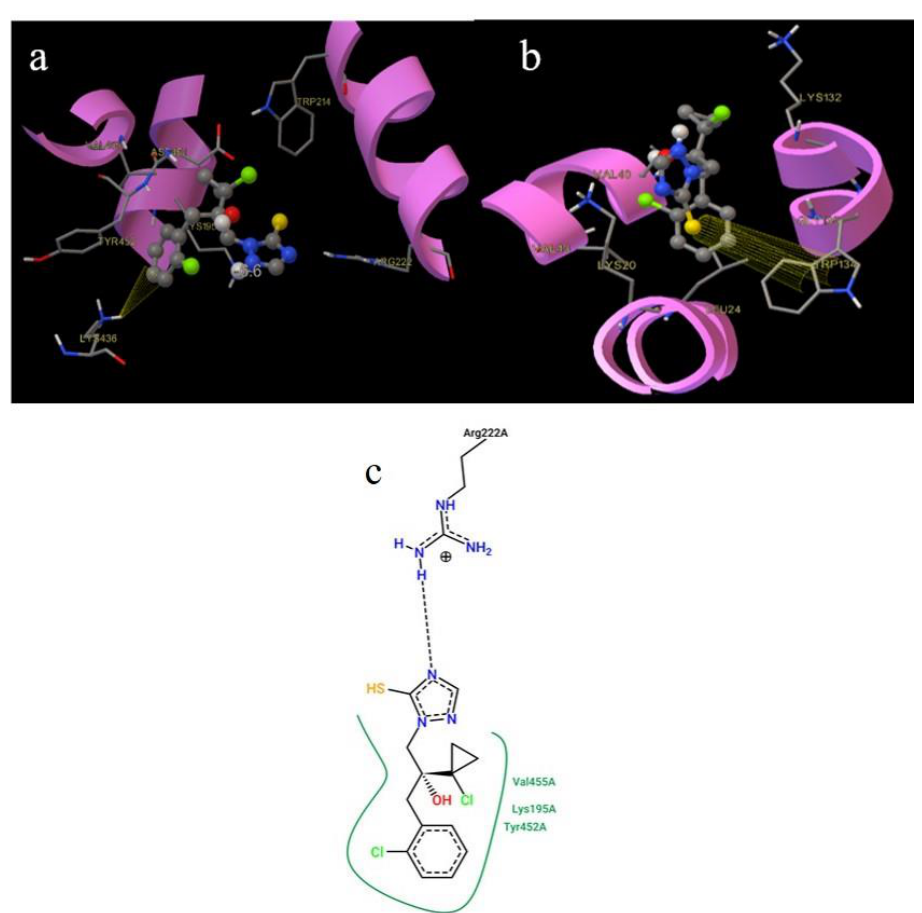
Figure 12. 3D representations of prothioconazole (PTC) in human serum albumin (HSA) ( a ) and bovine serum albumin (BSA) ( b ) Sudlow site I. 2D representation of PTC in HSA ( c ).